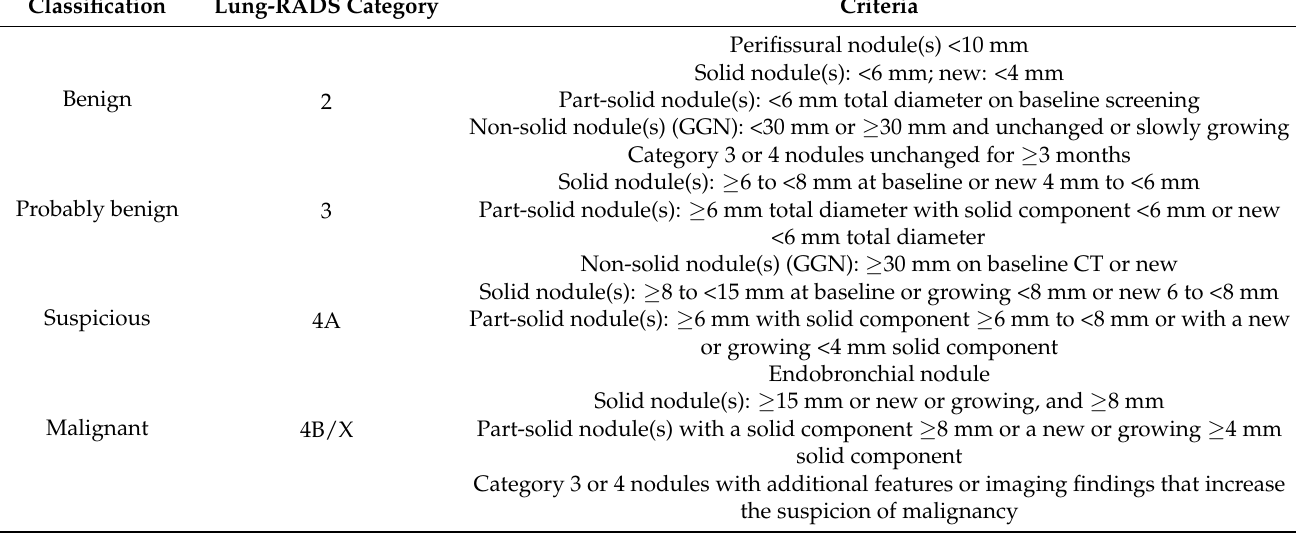
Table 6. Lung-RADS classification.